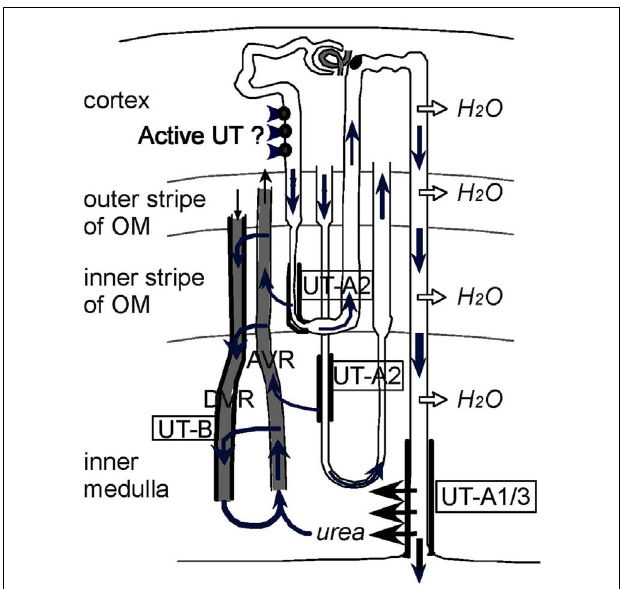
FIGURE 1 | Diagram depicting the vascular and tubular routes of urea recycling within the kidney. A short and a long-loop of Henle are depicted within the four kidney zones, along with a descending vasa recta (DVR) and an ascending vasa recta (AVR). OM is defined as outer medulla. In normal mice, concentrated urea is delivered to the tip of the papilla by the terminal part of the collecting ducts expressing the vasopressin-regulated urea transporters UT-A1/3. Urea is taken up by ascending blood (plasma and red blood cells) in AVR, and a significant fraction of it is returned to the IM by being reintroduced either in the DVR (expressing UT-B) or in the descending thin limbs of Henle’s loops (expressing UT-A2). Reproduced from Lei et al.